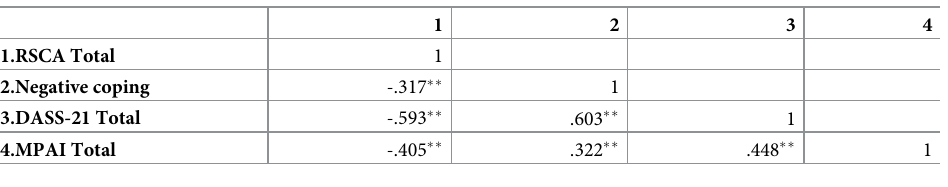
Table 3. Correlation analysis of study